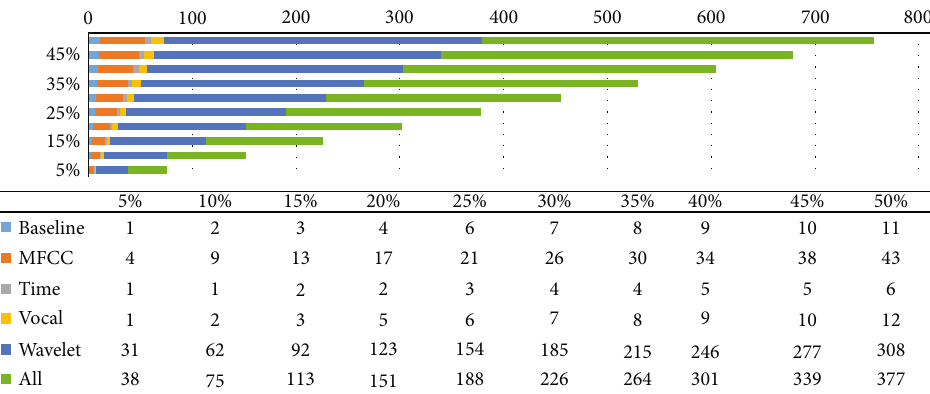
Figure 4: Attribute ranking in data groups.